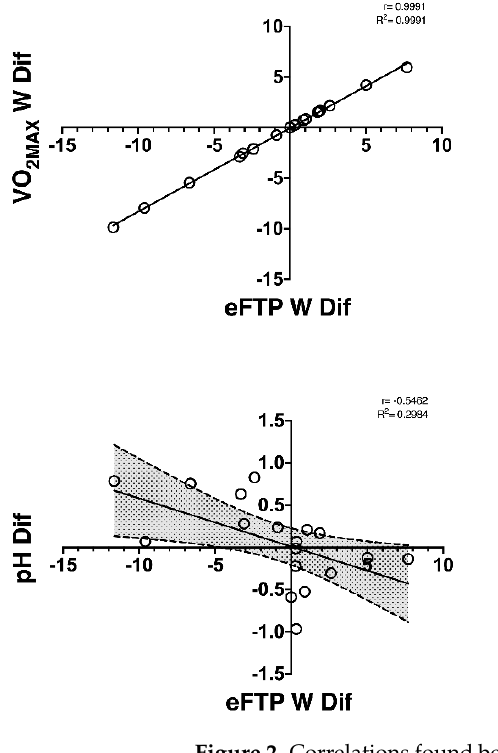
Figure 2. Correlations found between performance variables (the VO 2MAX W and eFTP) and capillary blood gases after an incremental test at the end of the off-season period in well-trained cyclists. All correlations were significant <0.05.